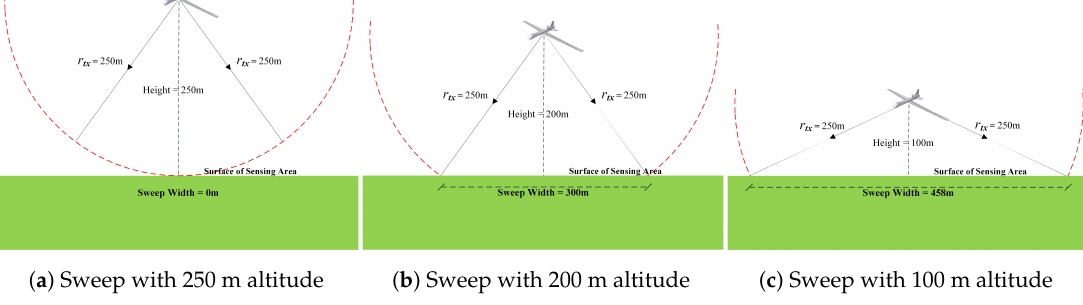
Figure 2. Illustration of the sweep width with different UAV altitudes. Sweep width depends on the altitude of the